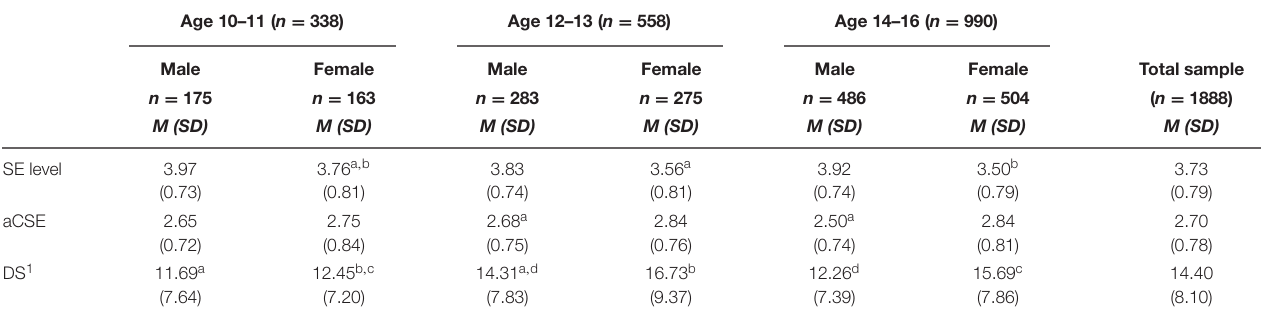
TABLE 2 | Mean scores and standard deviations of self-esteem (SE) level, aCSE, and DS by age and gender. Age 10–11 ( n =